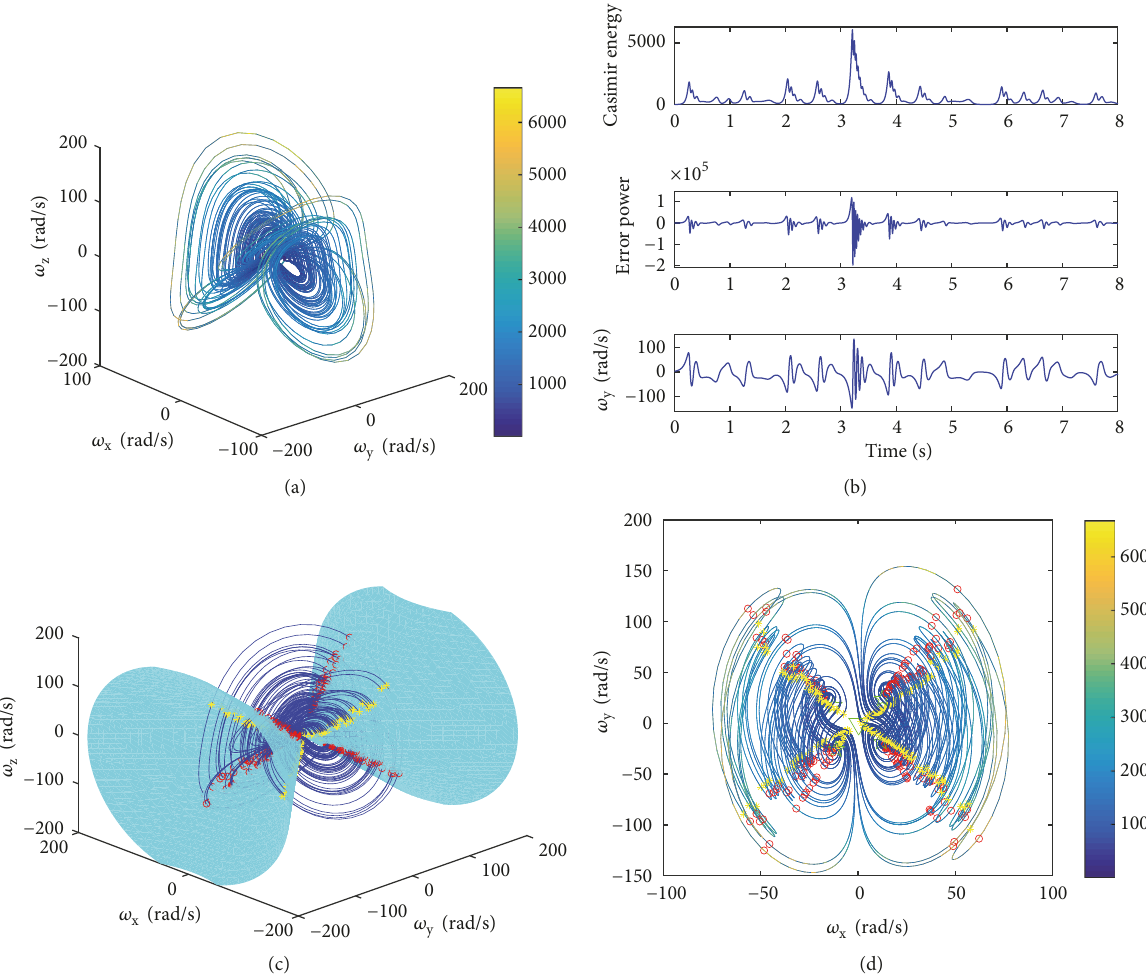
Figure 4: System under full torques. (a) 3D orbits with flowing stored energy, (b) time series of the stored energy, error power, and angular velocity 𝜔 𝑥 , (c) intersection of the chaotic system trajectory and hyperboloid of the Casimir function, the maxima and minima of which are marked by red circles and yellow stars, respectively, and (d) signs of extrema and equilibrium points on the four-wing chaotic